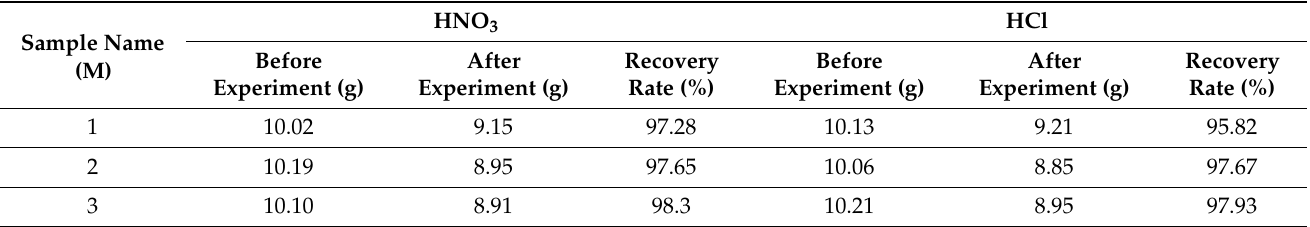
Table 3. Weight of a photovoltaic cell before and after the experiment and Si recovery rates— concentration (unit: